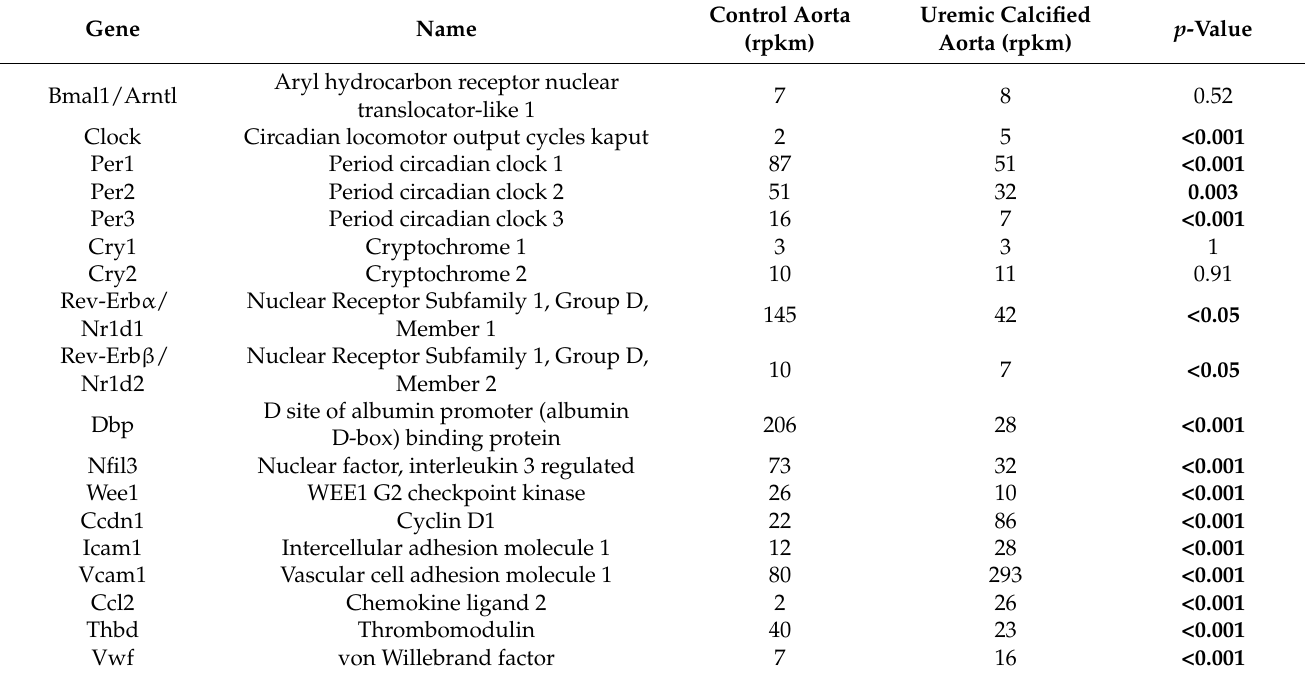
Table 1. Circadian clock and clock-controlled genes in the uremic calcified aorta. Vascular calcification was induced by long-term uremia and a treatment with calcitriol. The aorta gene expressions were analyzed by